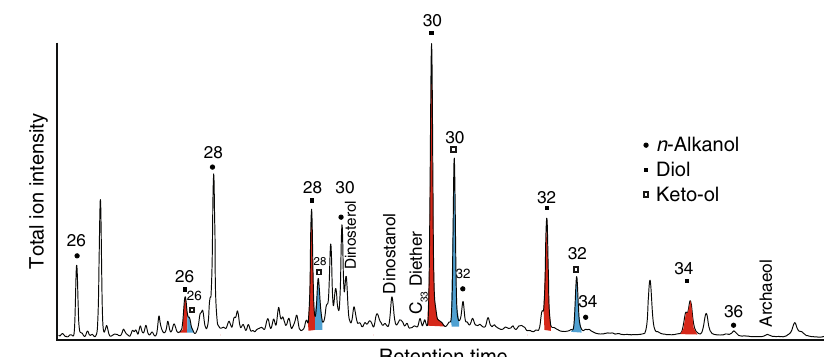
Fig. 5 Biomarker distribution for + 15 concretion. Chromatogram showing the biomarker distribution from + 15 concretion.